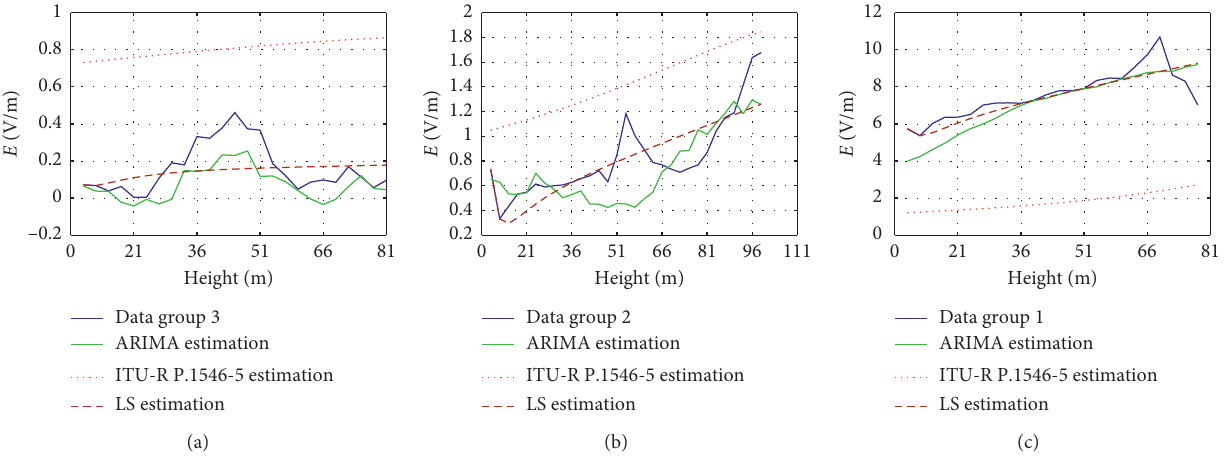
Figure 13: ARIMA estimation for (a) “data3” with tendency reintegrated ( 􏽢 L with tendency reintegrated ( 􏽢 L